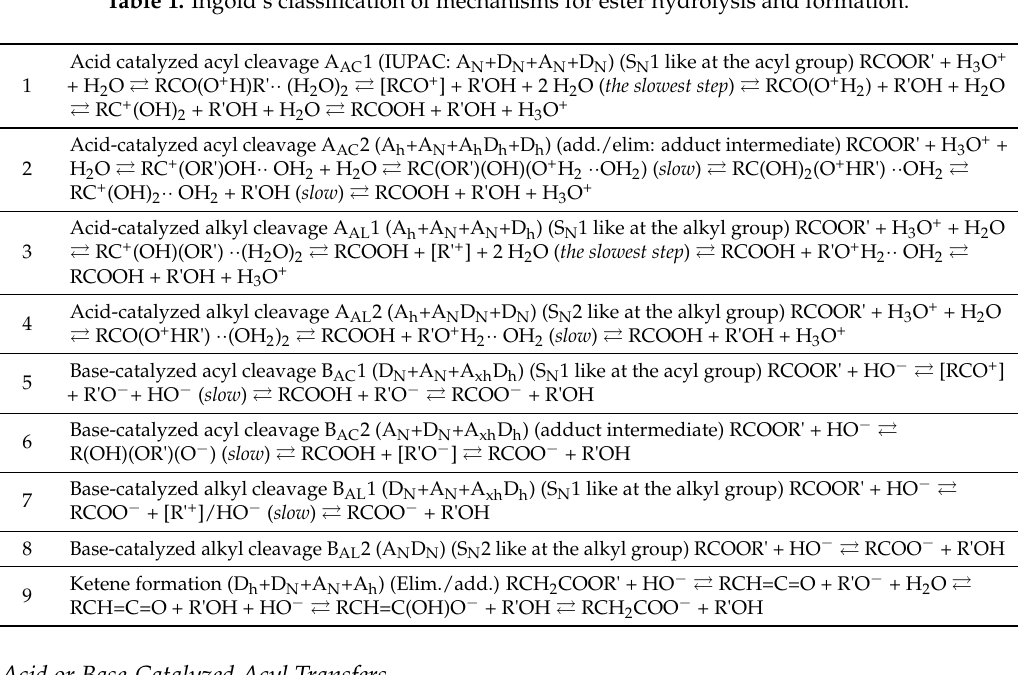
Table 1. Ingold’s classification of mechanisms for ester hydrolysis and